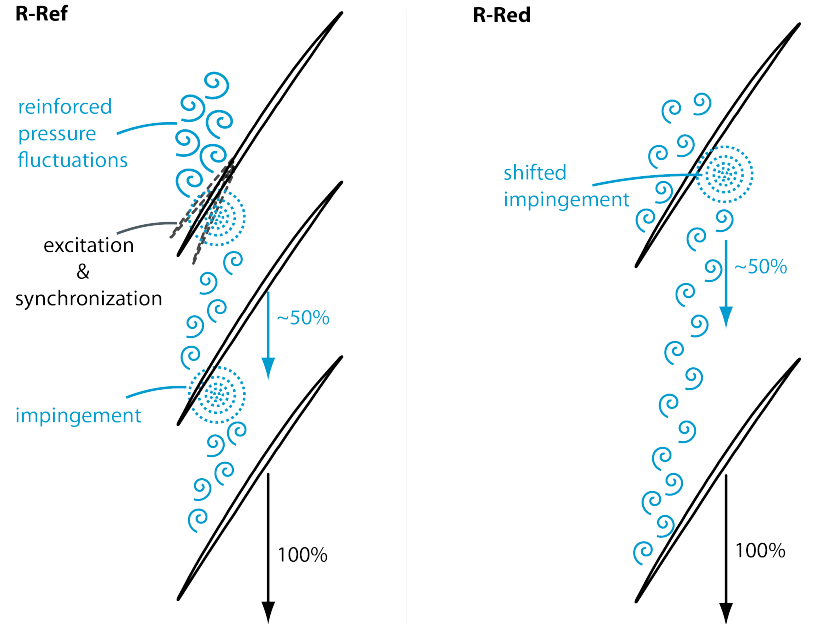
Figure 11. Schematic Sketch of Blade Count Influence on